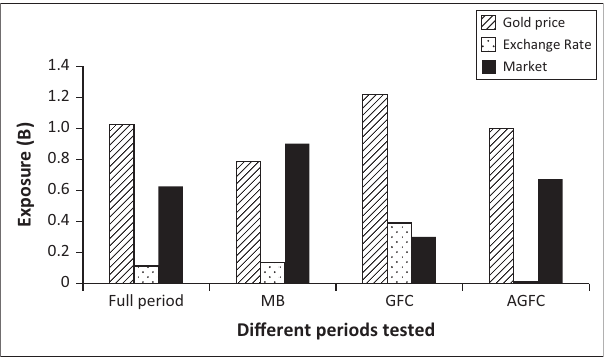
FIGURE 3: Exposure of returns (measured by the respective β s) to the variables in Equation 5 for the full period and